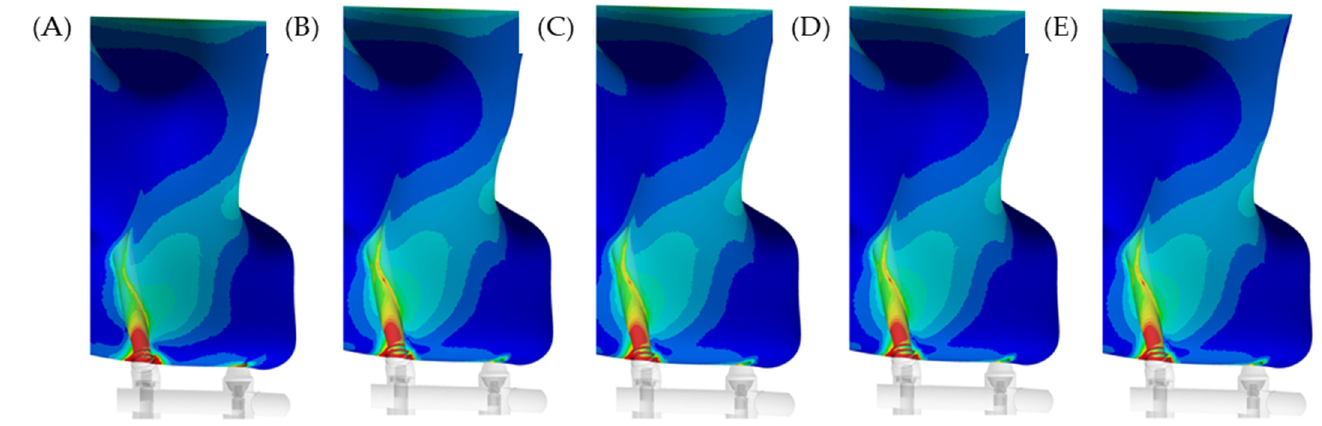
Figure 6. Lateral view of the microstrain distribution in the maxillary bone according to the different superstructure materials. ( A ) PEEK, ( B ) CF, ( C ) Ti, ( D ) CoCr and ( E ) Zi. In this view, the red area with high stress can be reduced as the superstructure stiffer increases.